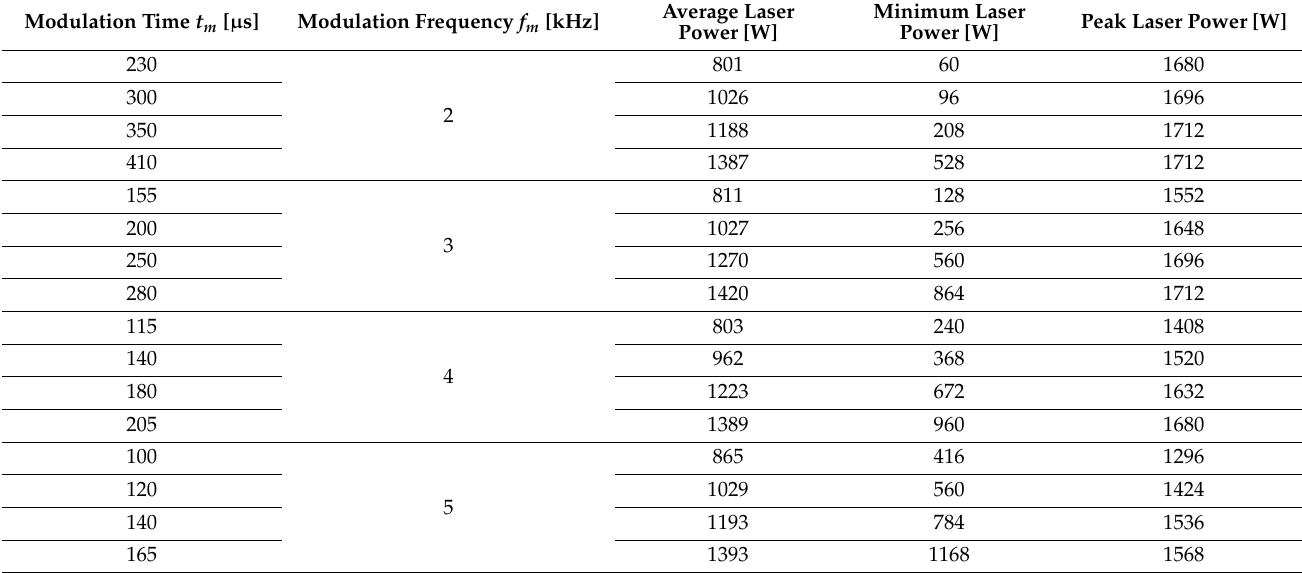
Table 3. Measured laser modulation characteristic with average, minimum and peak laser power depending on the modulation time t m and modulation frequency f m .